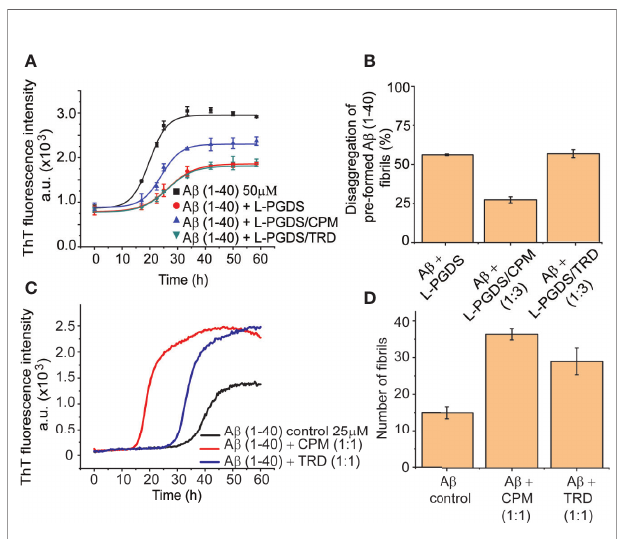
FIGURE 2 | Inhibitory effects of L-PGDS and L-PGDS/drug complex on A b (1 – 40) peptide aggregation. (A) Representative time course of spontaneous A b (1 – 40) peptide aggregation in the absence (black) or presence of L-PGDS in 1:10 (protein:peptide) ratio (red) or presence of L- PGDS/CPM complex in ratio 1:3 (protein:drug) ratio (blue) or resence of L- PGDS/TRD complex in ratio 1:3 (protein:drug) ratio (green). (B) Disaggregation of preformed A b (1 – 40) fi brils by L-PGDS or L-PGDS/CPM complex in 1:3 (protein:drug) ratio and L-PGDS/TRD complex in 1:3 (protein: drug) ratio. Data shown are means ± SEM (n = 6). (C) Representative time course of spontaneous A b (1 – 40) peptide aggregation in the absence of compounds (black) or presence CPM in 1:1 ratio (red) or presence TRD in 1:1 ratio (blue). (D) Number of fi brils for each condition measured from the TEM